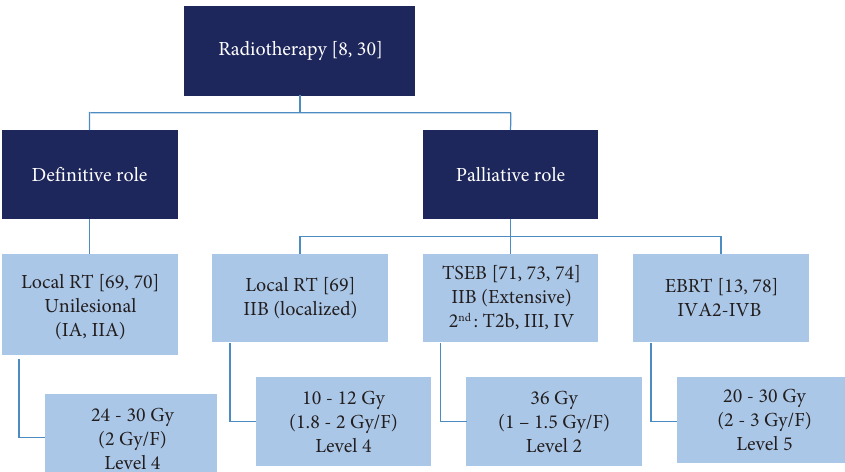
Figure 1: Protocol of radiotherapy treatment for MF/SS in Egypt. Localized radiotherapy is given to unilesional MF or nodular-stage MF with few nodules. TSEB is given to nodular-stage MF with extensive nodules or as a second-line therapy for resistant plaques, erythroderma, or stage IV. EBRTcan be given in case of metastasis. RT: radiotherapy, TSEB: total skin electron beam, EBRT: external beam